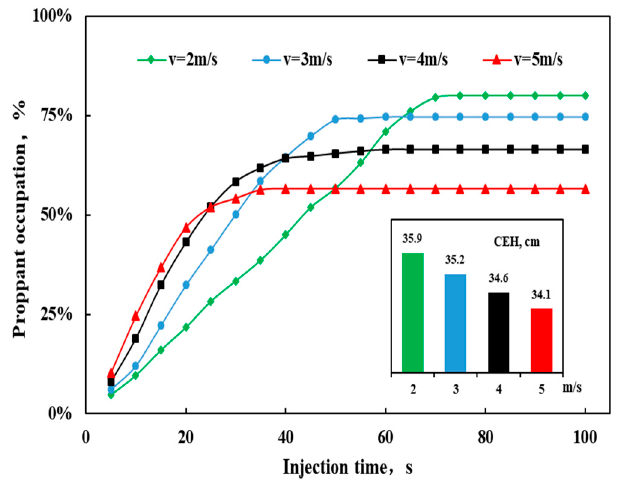
Figure 10. Proppant occupation percentage in fracture change with time a comprehensive equilibrium height (CEH) for different velocity cases.